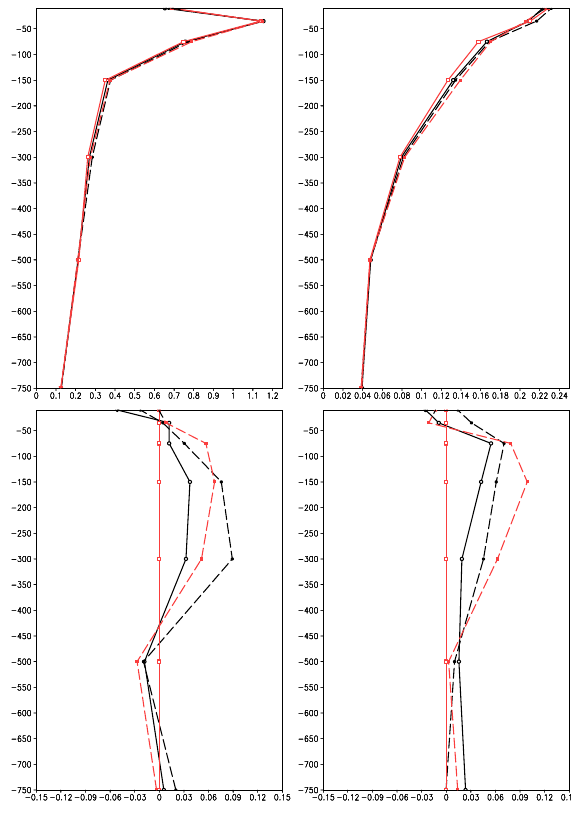
Fig. 6. The RMS of temperature ( ◦ C) (top left) and salinity (top right) residuals calculated with respect to observations by Argo floats in ATPR1 (continuous red line), ATPR2 (dashed red line), CONT1 (continuous black line) and CONT2 (dashed black line) during all of 2009. The difference between RMS of residuals from ATPR1 and ATPR1 (continuous red line), ATPR2 (dashed red line), CONT1 (continuous black line) and CONT2 (dashed black line) normalized by the RMS of residuals in ATPR1 for temperature (bot- tom left) and salinity (bottom